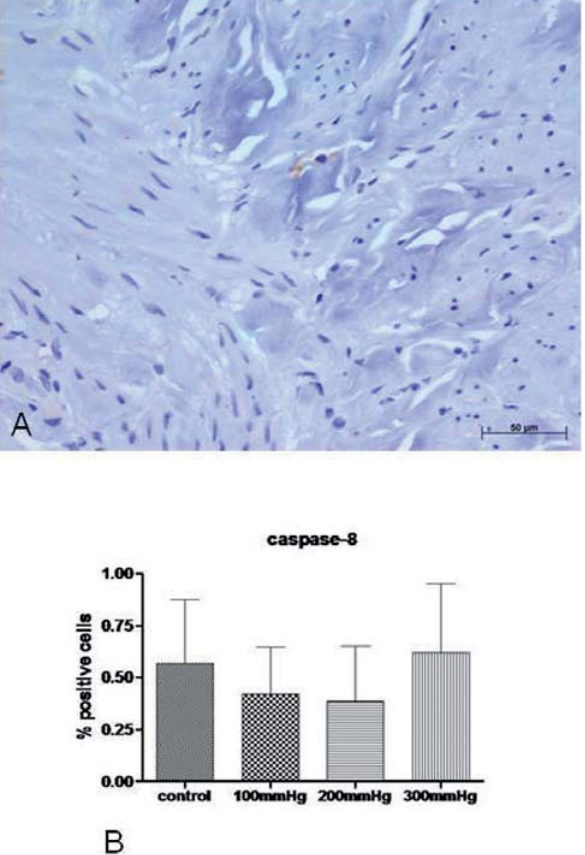
Fig. 1 - Representative photomicrograph of immunohistochemical analysis for expression of caspase 3 in segments of vein submitted for fifteen seconds at 300 mmHg (A): original magnification 400X.